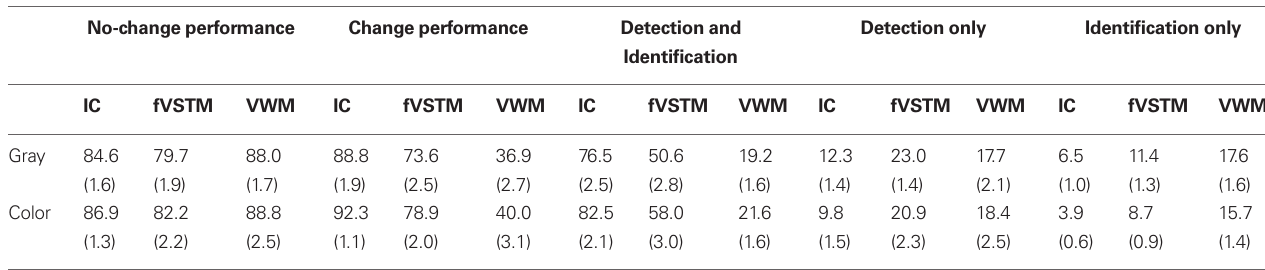
Table 1 | Performance on different VSTM